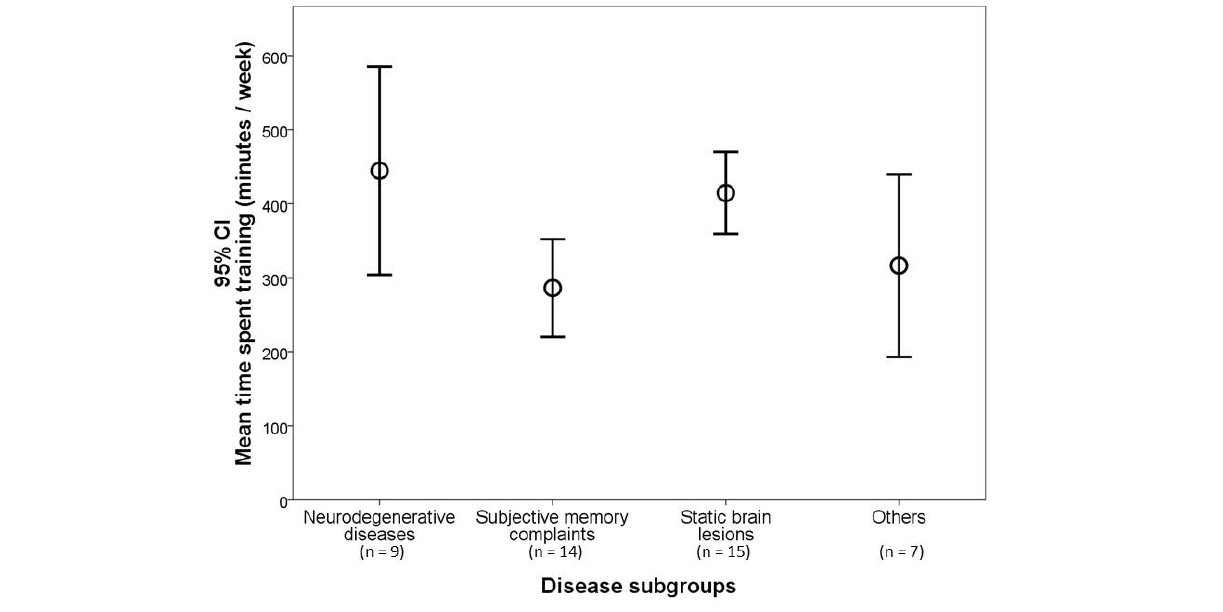
Figure 2. Time spent training (average in minutes/week) per disease group.